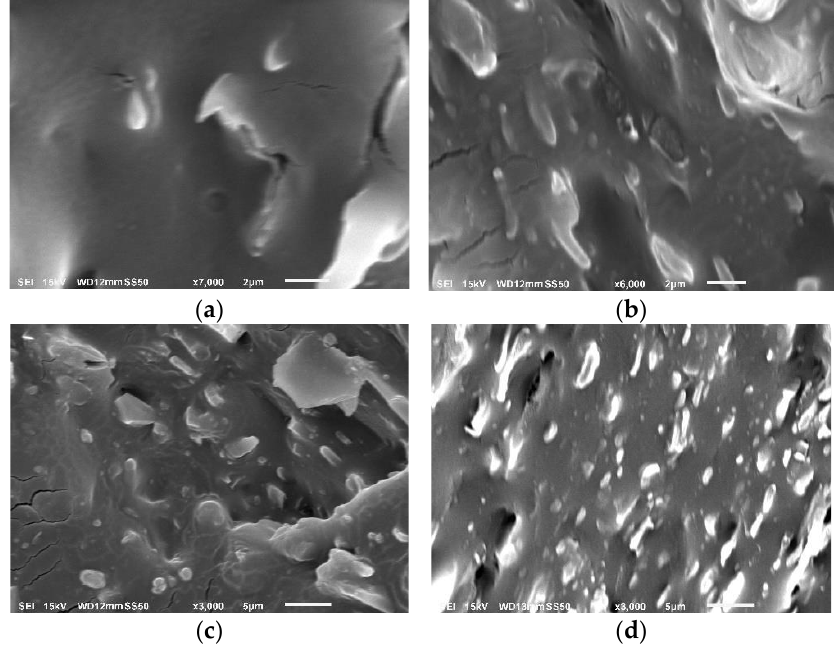
Figure 6. SEM images of 20:80 PLA/ENR ( a ); 30:70 PLA/ENR ( b , c ); 40:60 PLA/ENR ( d ).